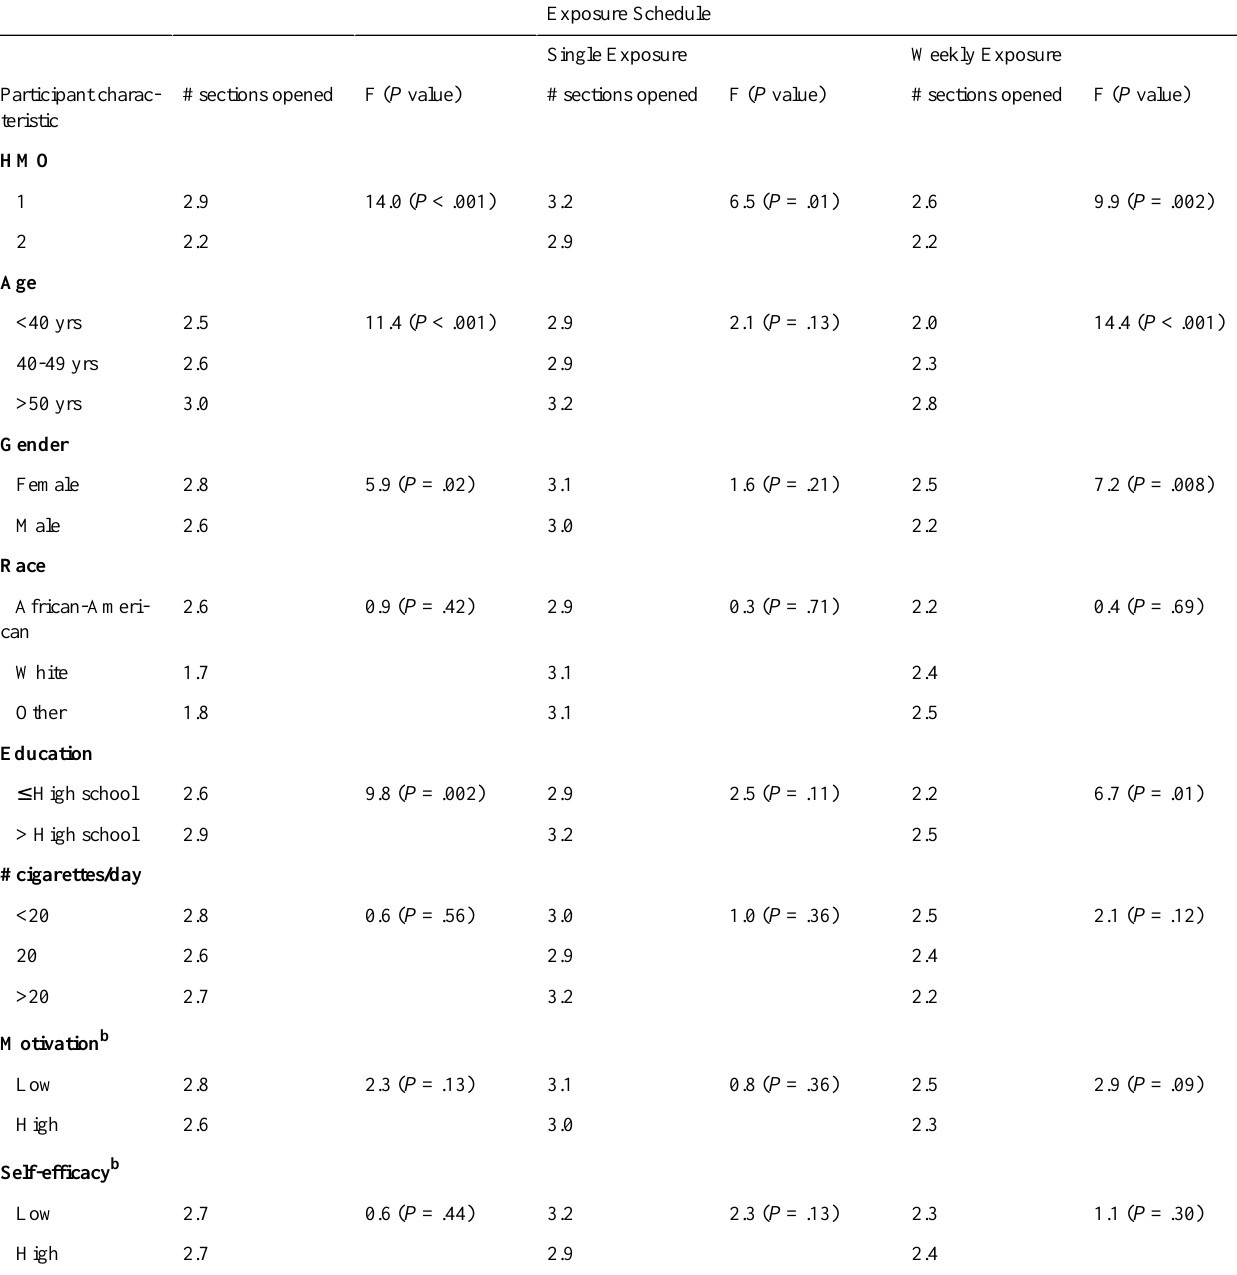
Table 2. Program engagement a of each intervention component by participant characteristics (n = 1866)